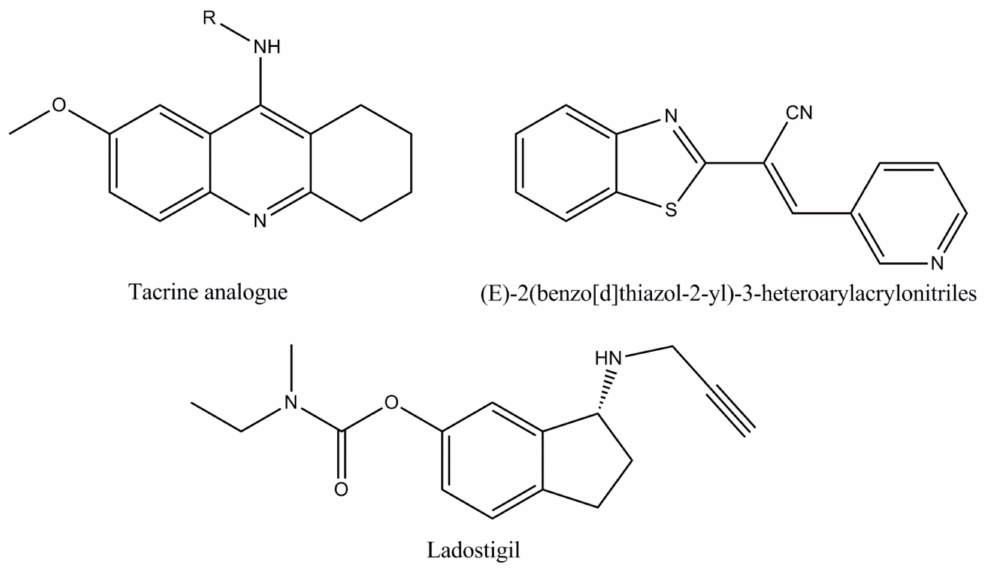
Figure 7. The molecular structures of synthetic analogues: Tacrine